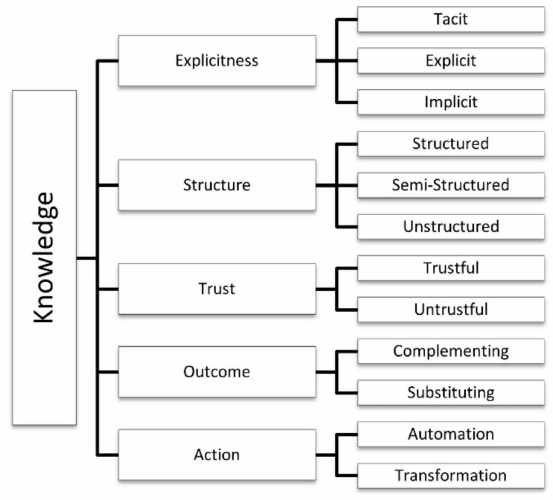
Figure 3. IoE Taxonomy: knowledge category with dimensions and